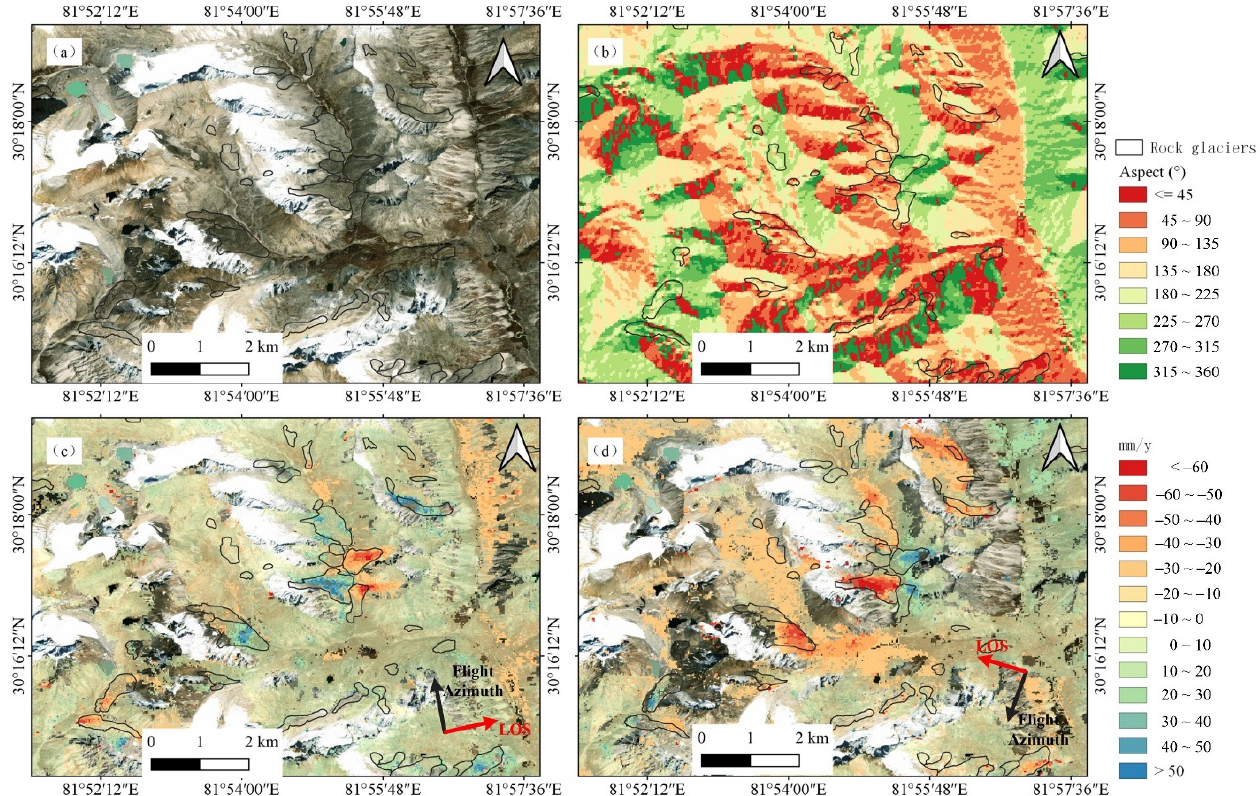
Figure 8. The line-of-sight (LOS) deformation characteristics of ascending and descending geometries in different aspects. ( a ) Bing optical images of typical rock glaciers. ( b ) Aspect distributions of specific rock glaciers. ( c ) LOS deformation rate in ascending geometry. ( d ) The LOS deformation rate in descending geometry.